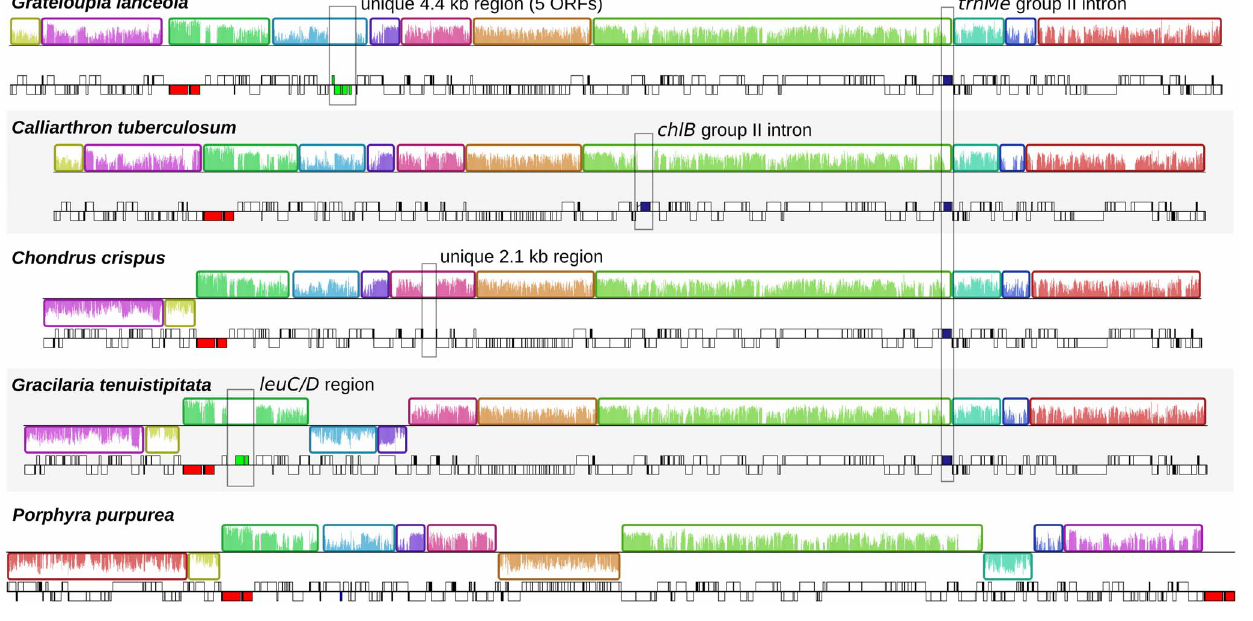
Figure 1. Overview of red algal plastid genomes. Linearized maps of complete florideophyte plastid genomes compared with the bangialean Porphyra . For each genome, colour-coded syntenic blocks are shown above and gene maps are shown below. Syntenic blocks above the horizontal line are in the same strand while those below the line are on the opposite strand. Horizontal bars inside the syntenic blocks show sequence conservation. Block boundaries correspond to sites where inversion events occurred. In gene maps, genes above the horizontal line are transcribed left to right while those below are transcribed from right to left. Unique regions are boxed with genes in green, regions with introns are boxed with intronic segments in blue, and rRNA operons are red. doi:10.1371/journal.pone.0059001.g001 PLOS ONE |